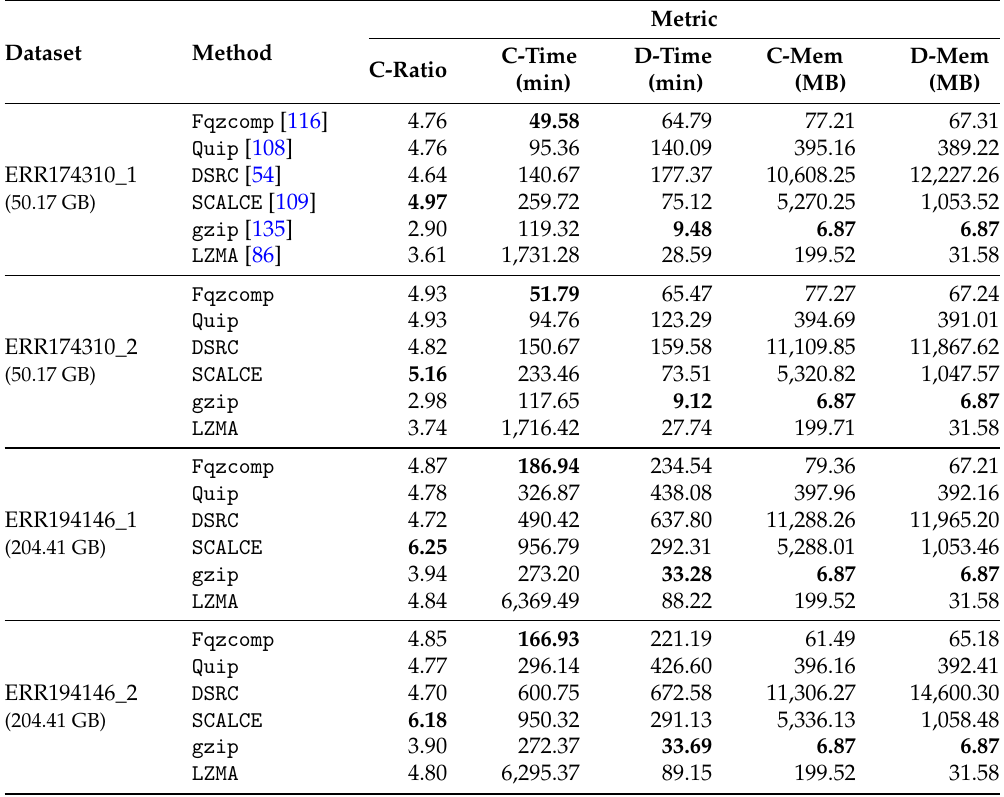
Table 4. Reference-free compression results of genomic sequence data for FASTQ file format.